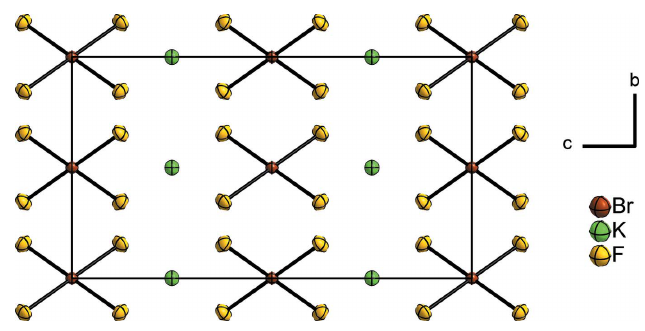
Figure 1 The crystal structure of K[BrF 4 ] in a projection along the a axis. Displacement ellipsoids are shown at the 70% probability level.